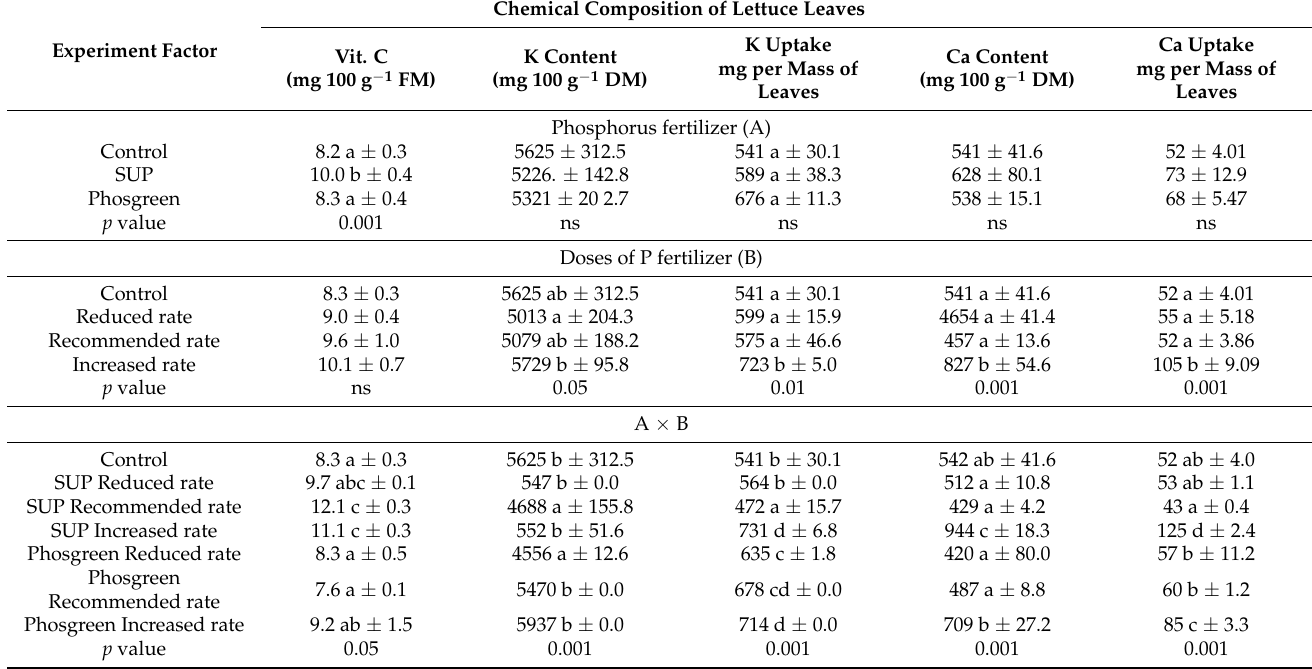
Table 2. The effect of SUP and Phosgreen fertilization on vitamin C, K, and Ca content and uptake in butterhead